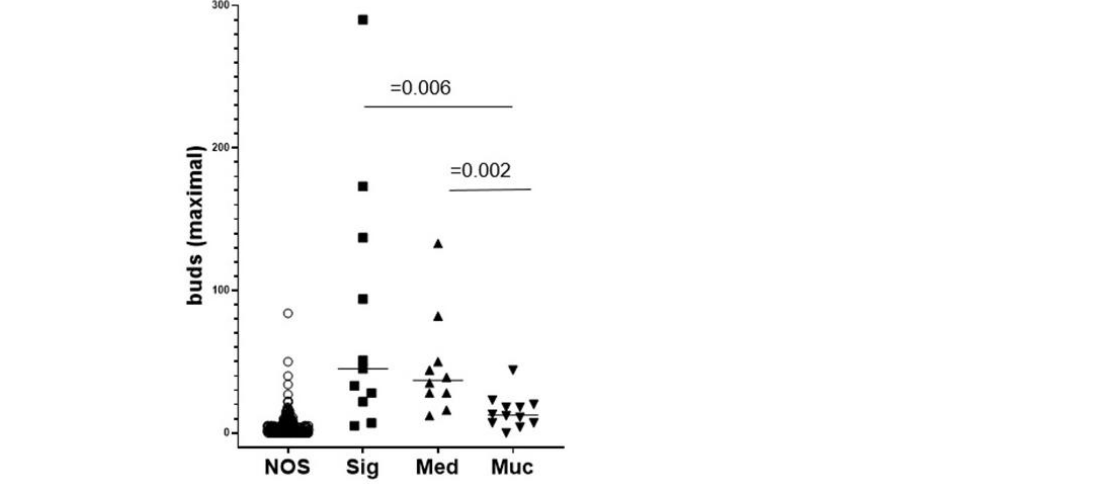
Figure 6. Comparison of NOS and histological subtypes regarding the distribution of max bud counts in each type of colon cancer using two-tailed, unpaired, and non-parametric Wilcoxon–Mann–Whitney testing. Calculated with SPSS Version 26, IBM (Armonk, New York, NY, USA). NOS compared with the subtypes of signet ring cell, medullary, and mucinous adenocarcinoma ( p < 0.001). It can be seen that for NOS and mucinous carcinomas, most patients have low ITB scores. For signet ring cell and medullary carcinoma, however, most patients are in the range corresponding to high ITB scores.